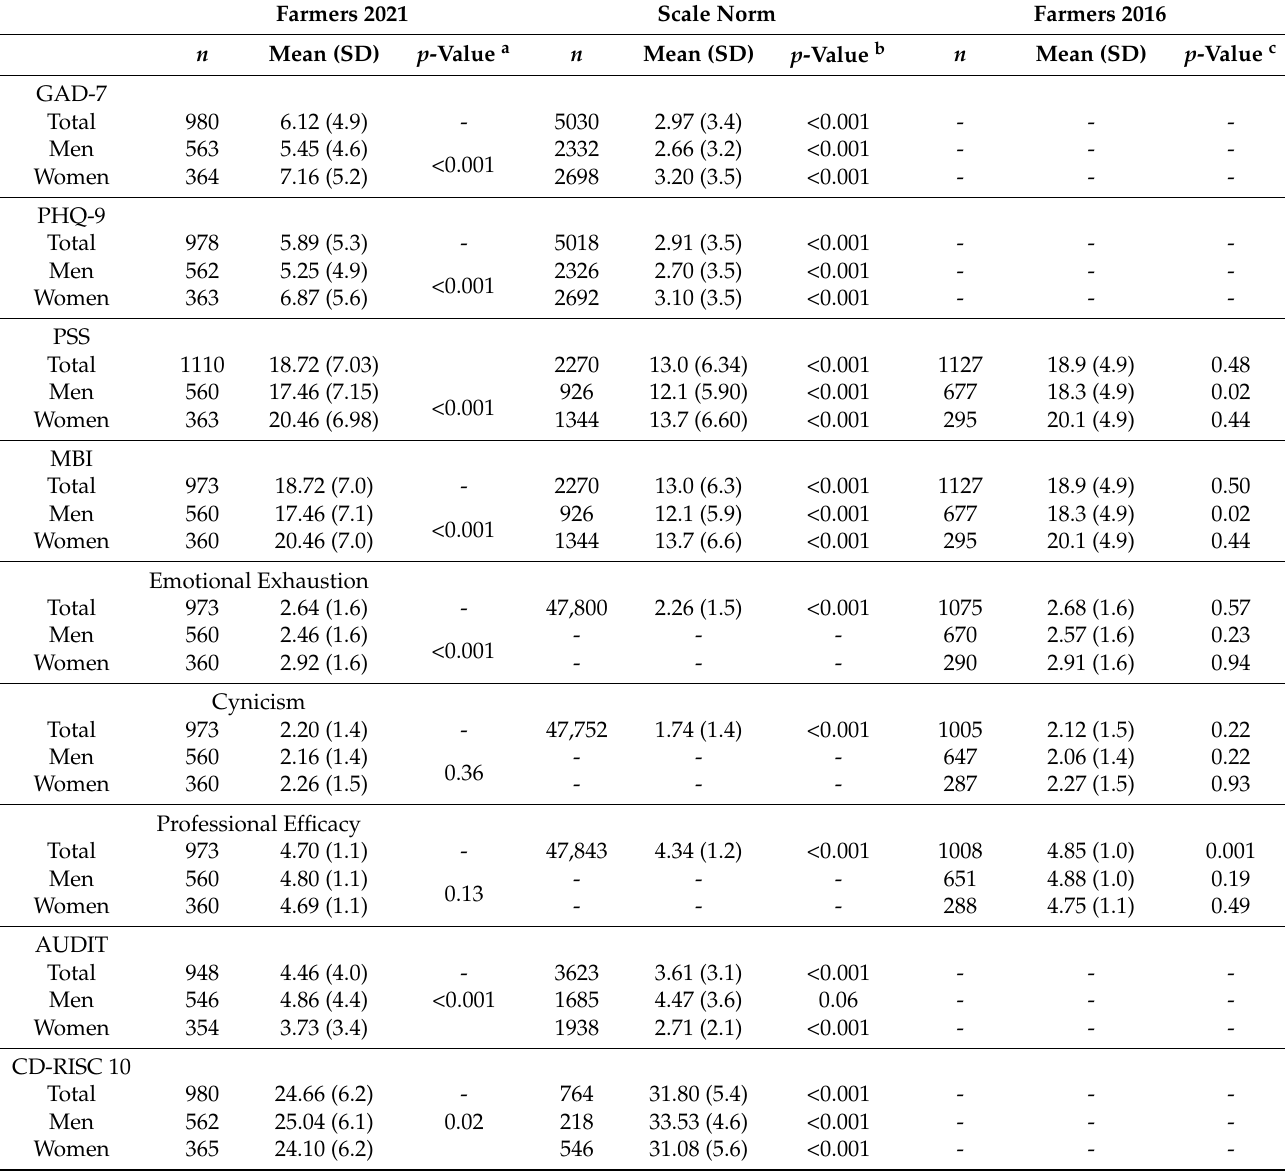
Table 3. Descriptive statistics ( n , mean, standard deviations) for each validated scale used for the overall 2021 sample and by gender, and with comparisons to scale population norms and 2015/2016 survey data, where